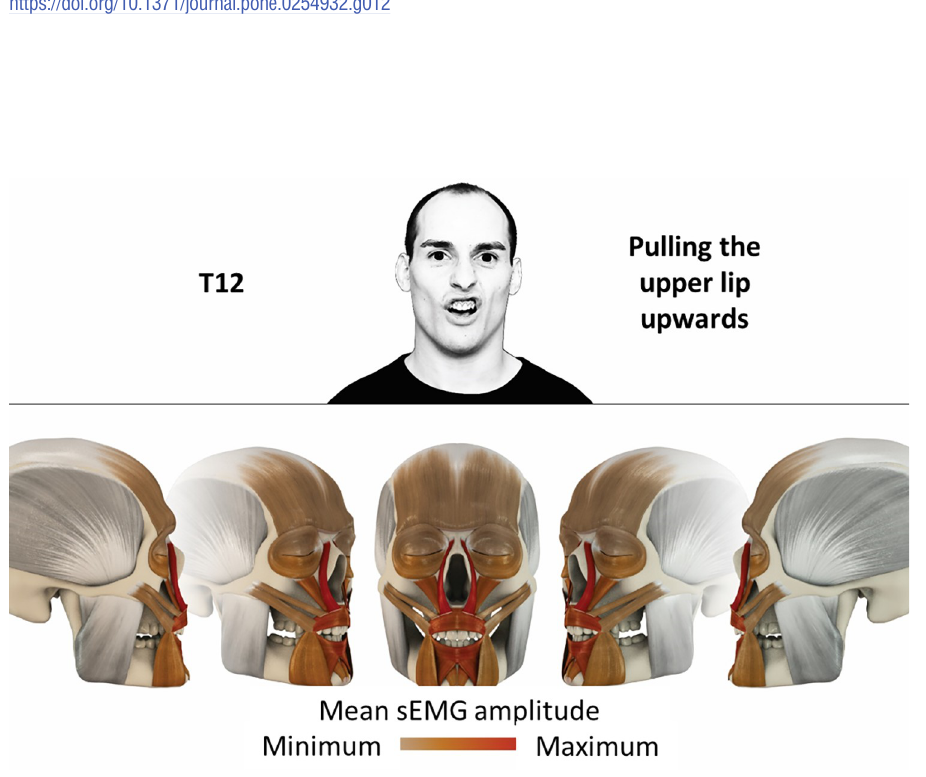
Fig 13. Color-coded facial muscle activation pattern of task T12. Pulling upper lip upwards. Animation by Jonas Laustro¨er.